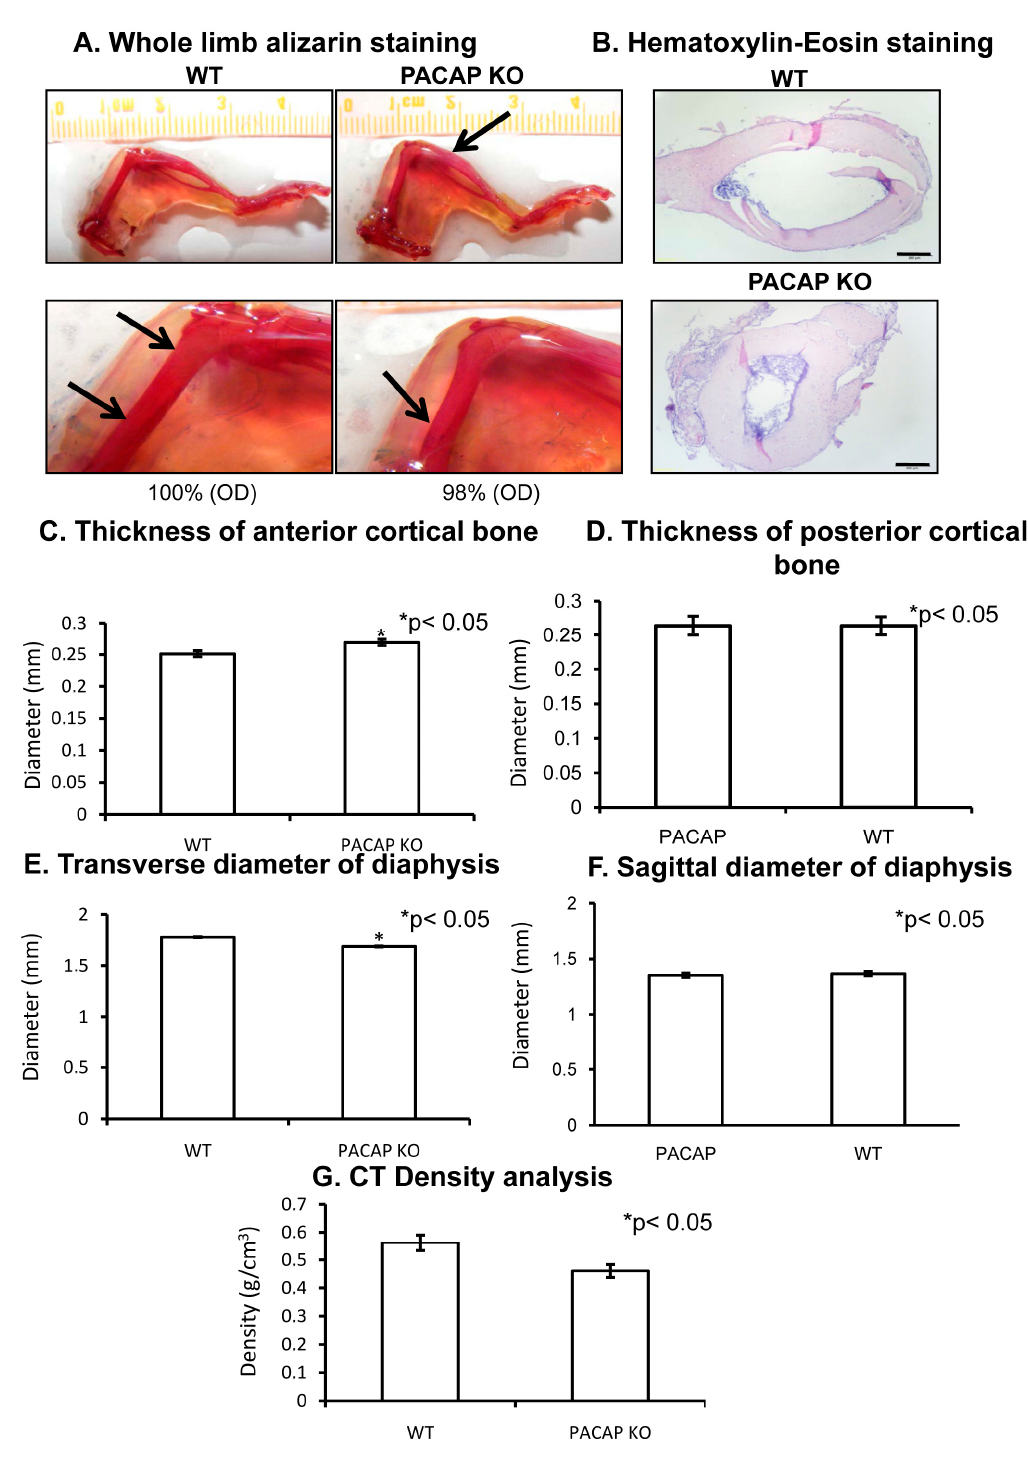
Figure 1. Morphological analysis of hind limbs of wild type (WT) and pituitary adenylate cyclase activating polypeptide (PACAP) knockout (KO) mice. Whole limb alizarin red staining ( A ), optical density (OD) was determined in 1 cm distal part of the femur. Hematoxilin-eosin (HE) staining ( B ) to visualize the histological differences. Original magnification was 4×. Scale bar, 500 µm. CT analysis ( C – G ) of mouse femurs. Representative data of 5 independent experiments. Asterisks indicate significant (* p < 0.05) difference in thickness of cortical bone or in the diameter of diaphysis compared to the respective control.